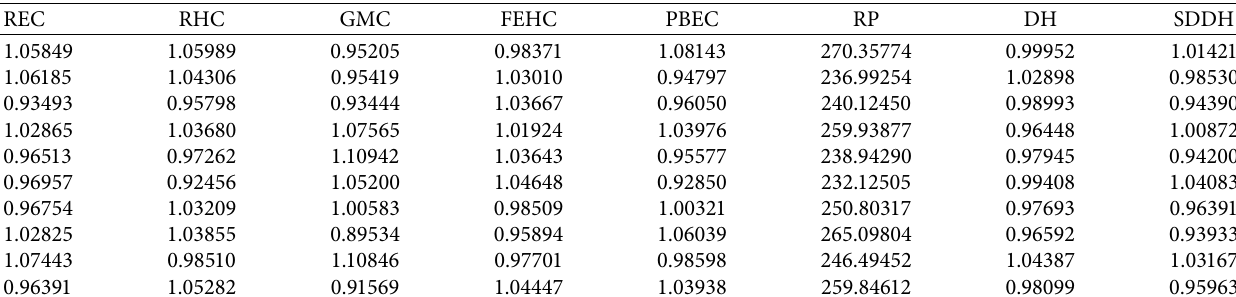
Figure 7: The relative covariance matrix generated by CUSA with sample size of 1000. (a) Generated by SRS. (b) Generated by LHS. (c) Generated by LHS-SVDC. Table 5: The first 10 of 100 sample population generated by CUSA for ATHENA